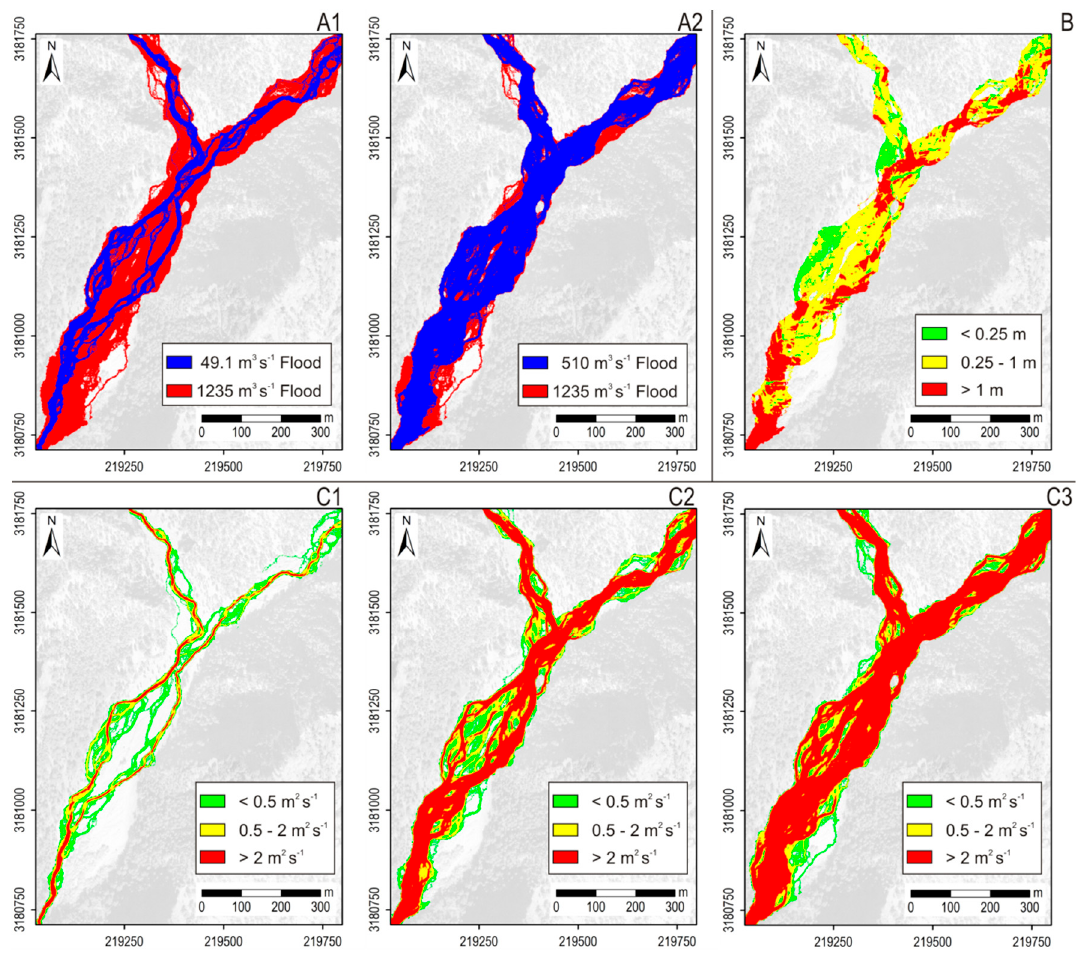
Figure 6. Hydraulic model outputs. Water surface extension ( A1 ) associated both 11–13 January 1997 precipitation event (49.1 m 3 s − 1 ) and liquid flow rate (1235 m 3 s − 1 ) with the lowest RMSE value in the comparison between the water surface heights and tree scar height (dendro-geomorphological evidence). Water surface extension ( A2 ) associated both 500-year return period rainfall (24-h duration hyetograph), 508 m 3 s − 1 , and 1235 m 3 s − 1 peak flow (lowest RMSE between water surface height and dendro-geomorphological evidence). ( B ) 1235 m 3 s − 1 and 508 m 3 s − 1 differences in water depth results. ( C ) delimitation of risk areas where people may suffer loss of stability due to flow, for different peak flows (( C1 ), 49.1 m 3 s − 1 ; ( C2 ), 508 m 3 s − 1 ; and ( C3 ), 1235 m 3 s − 1 ). X- and y-axis units are